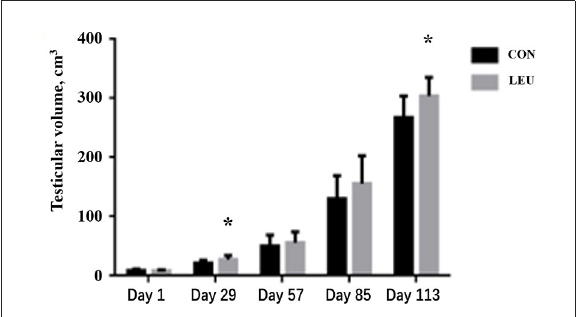
FIGURE1 Effect of dietary leucine supplementation on testicular volume in boars. CON, control group; LEU, leucine group. Values are means, with their standard errors represented by vertical bars ( n = 15), * means P < 0.05.